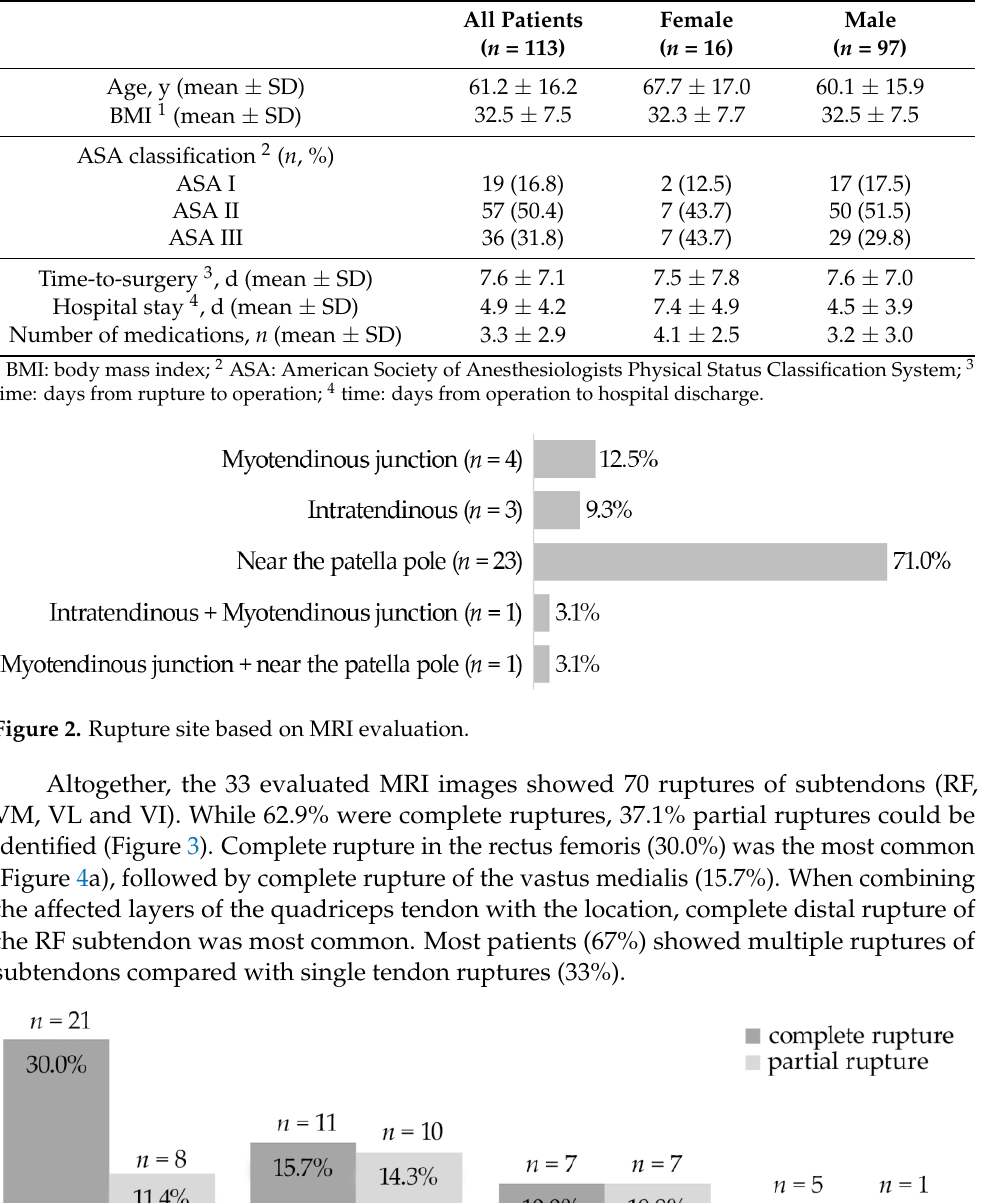
Table 1. Demographic data and patients ’ related characteristics.